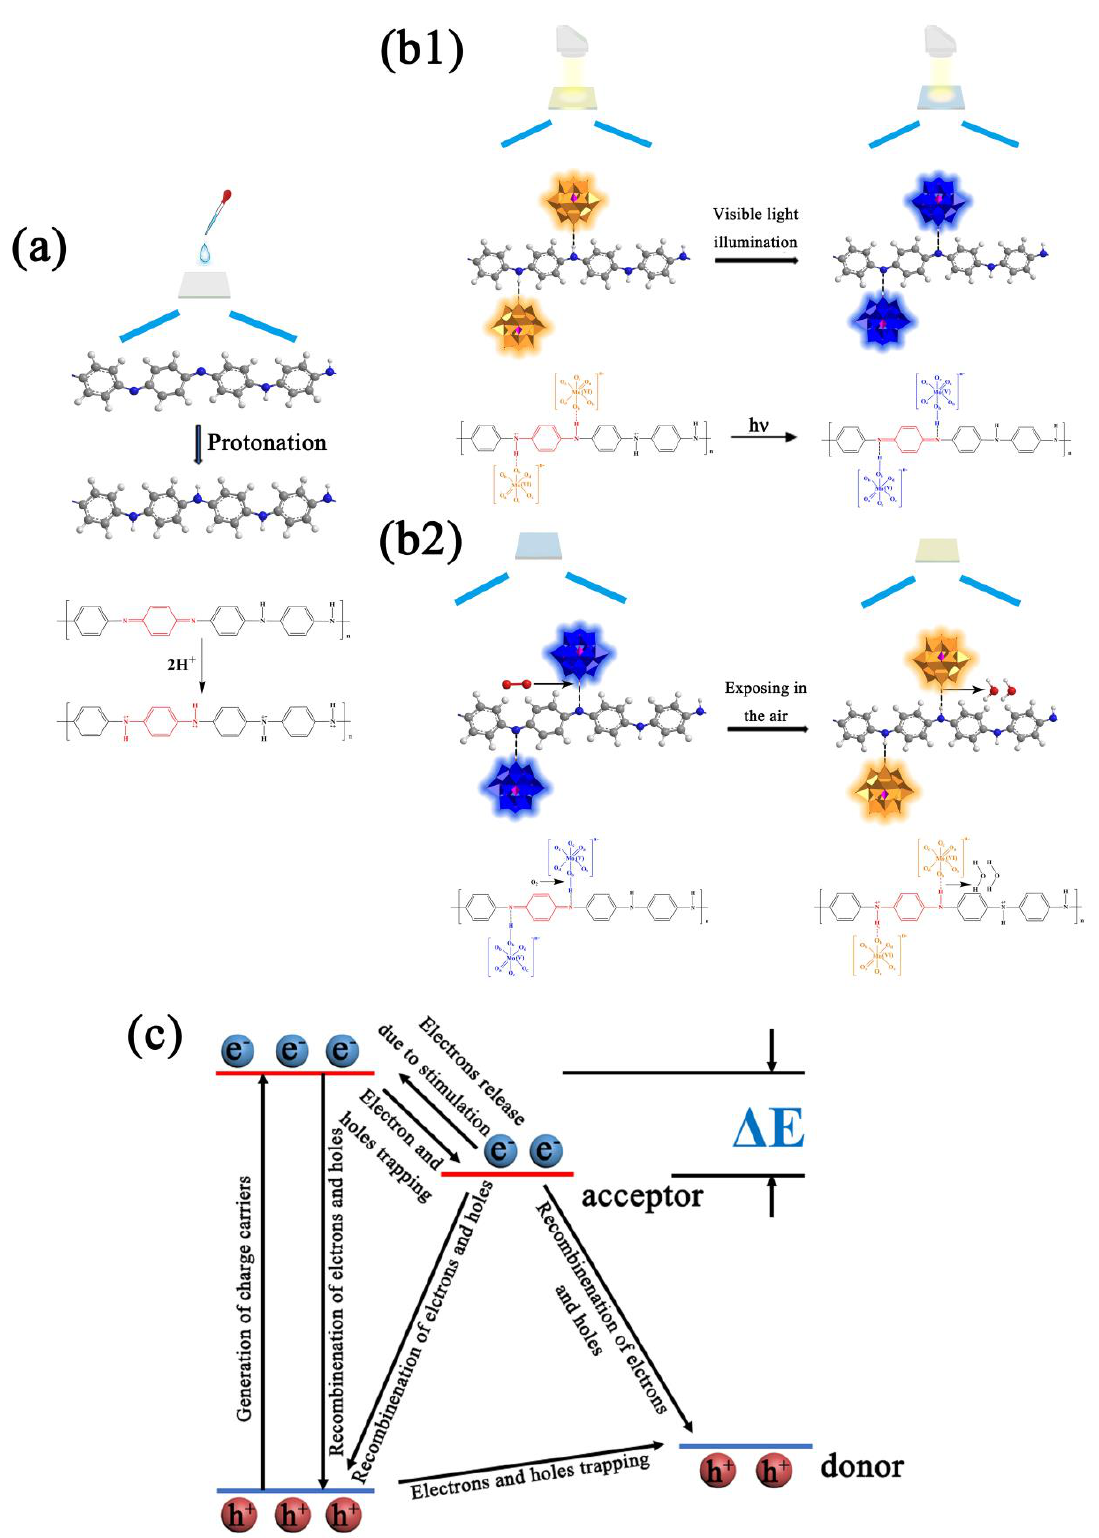
Figure 9. ( a ) The protonation process of PANI. ( b1 ) Process of coloration of the PMoA / PANI hybrid thin film. ( b2 ) Process of decoloration of the PMoA / PANI hybrid thin film in air. ( c ) Schematic diagram of LMCT.